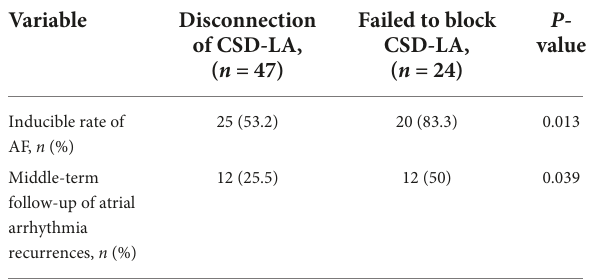
into the epicardial aspect if failed to endocardially block the CSD-LA ( n = 21, contrast). After ablating the target, the validated maneuvers for checking the presence of the CSD-LA were repeated once to confirm the disconnection or